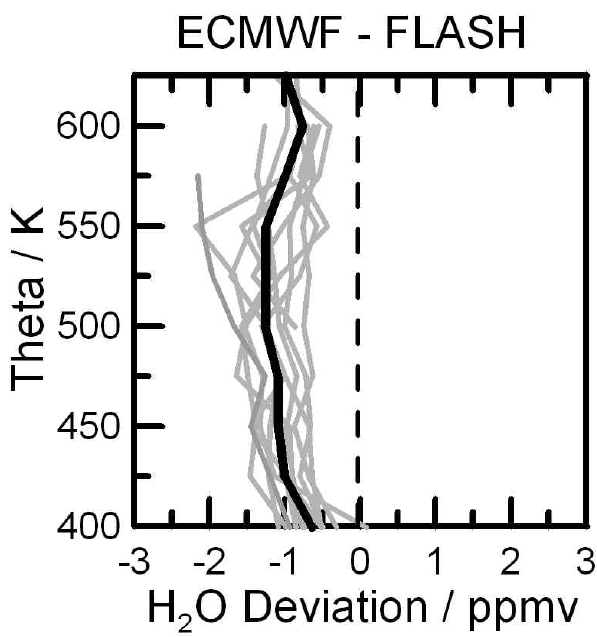
Fig. 2. Difference in water vapour mixing ratio between ECMWF T106 analyses and the 11 FLASH measurements (grey lines), the mean deviation profile (black line) revealing that the ECMWF anal- yses are about 1ppmv drier than the